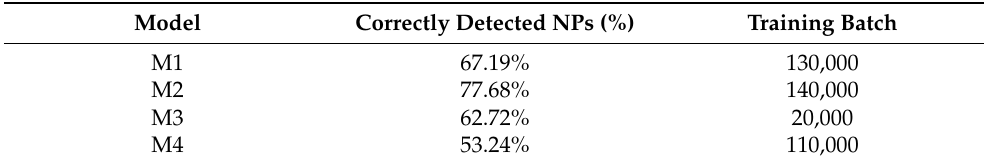
Table 5. Detection results for all models on the validation Dataset